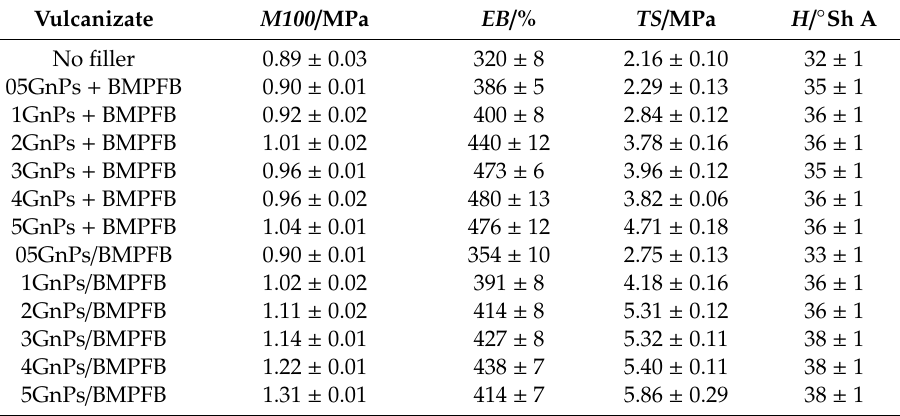
Table 6. Mechanical properties of SBR